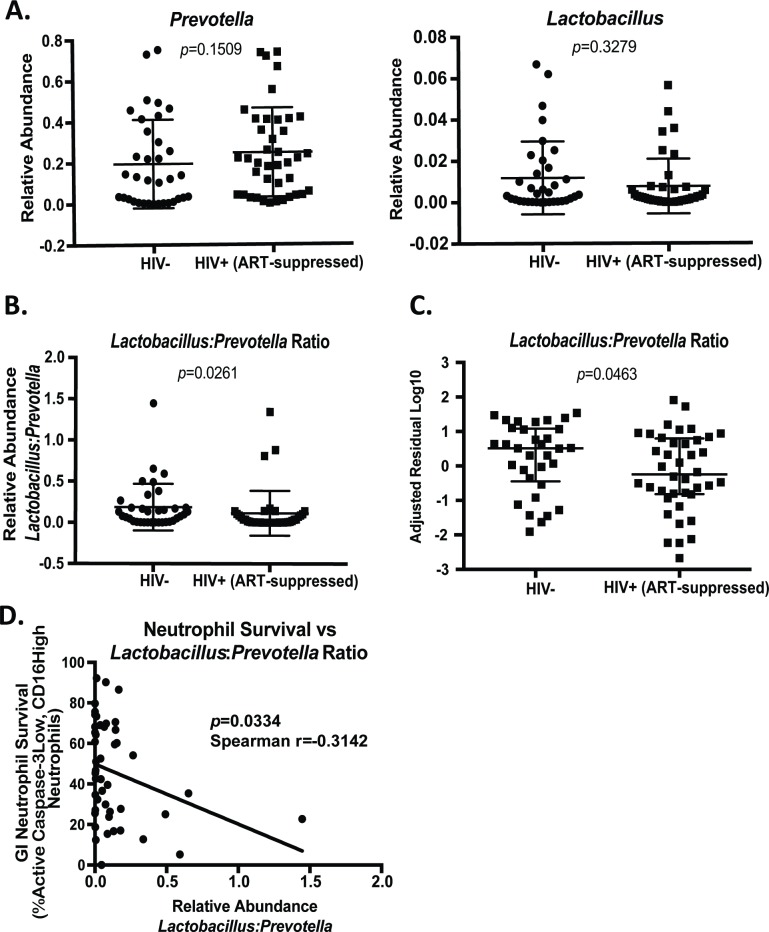
Lactobacillus:Prevotella ratio associates with GI Neutrophil survival in vivo.A.) Relative abundances of Prevotella and Lactobacillus genera in HIV-negative and HIV-positive, ART-suppressed individuals as measured by 16S rRNA sequencing of colorectal biopsies. B.) Ratio of Lactobacillus:Prevotella (relative abundances) in HIV-negative and HIV-positive, ART-suppressed individuals. C.) Depiction of the log10 residuals from data presented in (B) from a multivariate analysis adjusted for age, race, sex, and sexual orientation. D.) Correlation of Lactobacillus:Prevotella ratio and GI neutrophil survival as measured by the percentage of active Caspase-3 low, CD16 high neutrophils isolated from colorectal biopsies of HIV-negative and HIV-positive, ART-suppressed individuals. Statistical differences between infected and uninfected individuals (A and B) were assessed by Mann-Whitney test and a multivariate regression analysis (C) with a p-value<0.05 considered significant. Correlation assessed by Spearman rank correlation test.